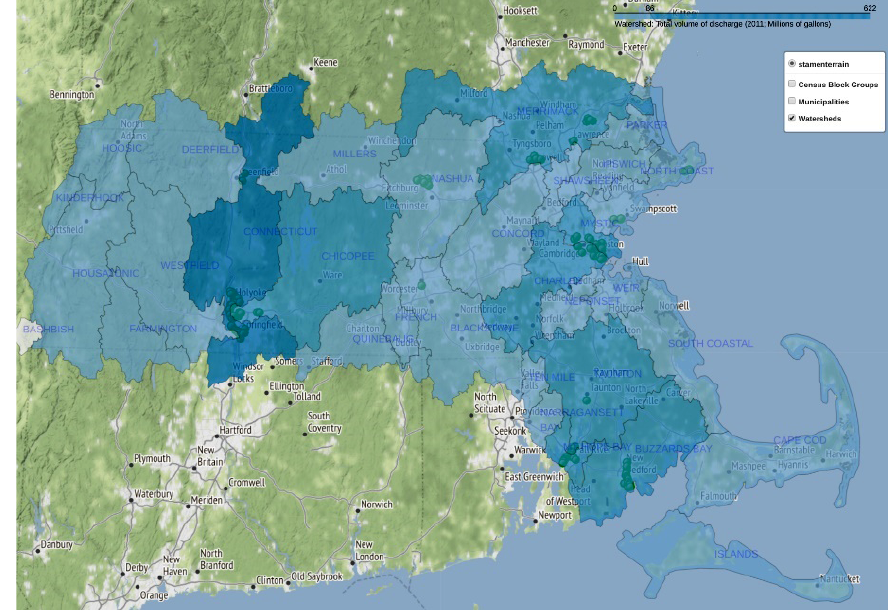
Figure 3. Interactive map of CSO locations and discharges per watershed and